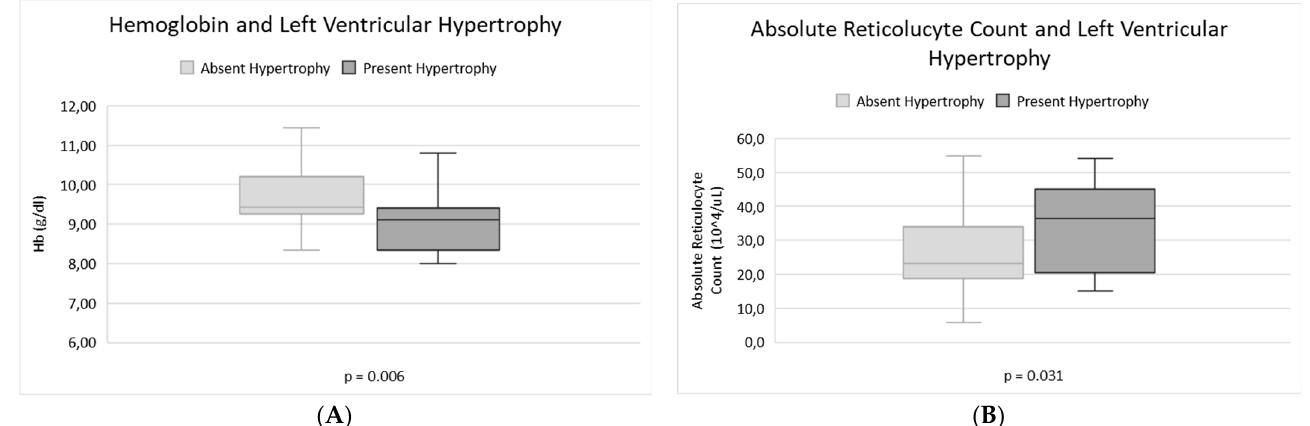
Figure 2. Correlation between LVH and markers of haemolytic anaemia. Box plot showing lower median Hb level ( A ), and increased absolute reticulocyte count ( B ) in patients with left ventricular Hypertrophy compared to patients without this echocardiography alteration.